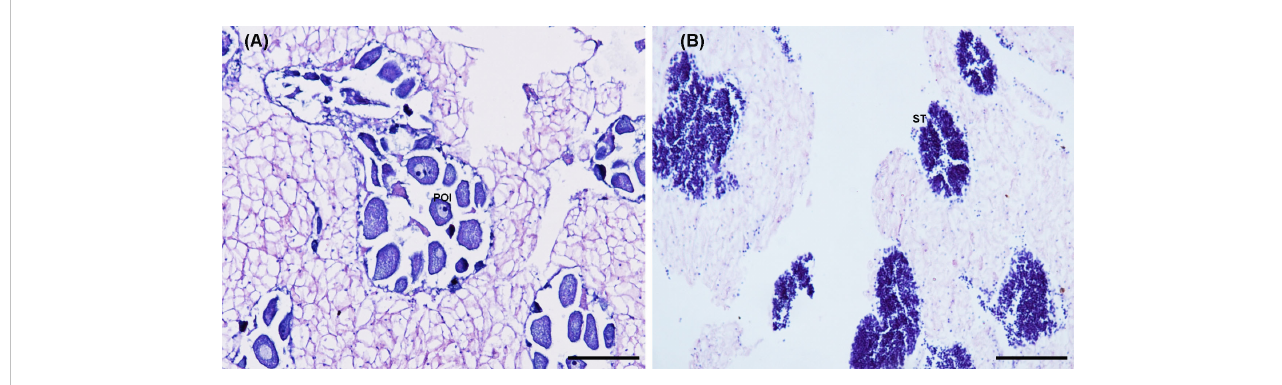
FIGURE 1 Histological characteristics of the ovary (A) and testis (B) of the C sinensis for transcriptome sequencing. POI, pre-vitellogenesis oocyte; ST: spermatid. Scale bars, 100 m